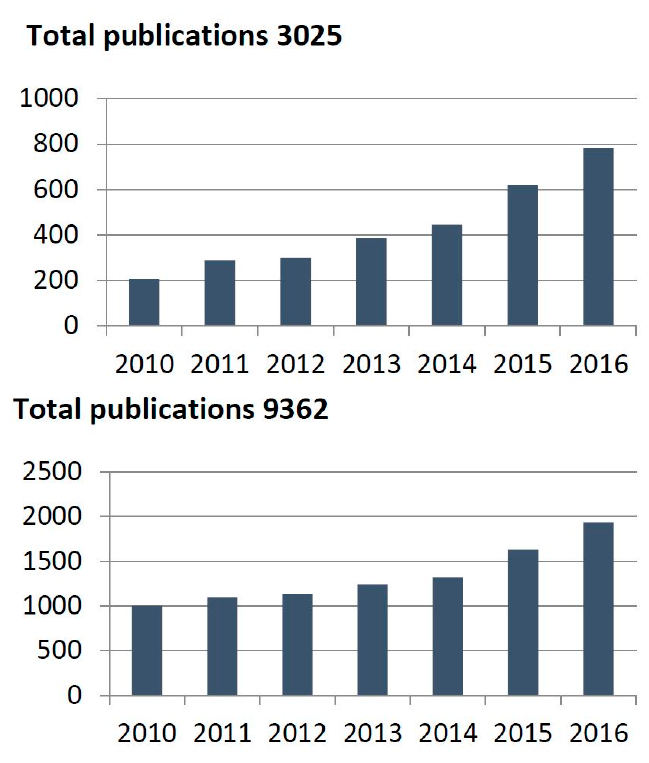
Figure 2. Total publications of AHP and TOPSIS methods between 2010 and 2016 (Source: Web of Science platform).